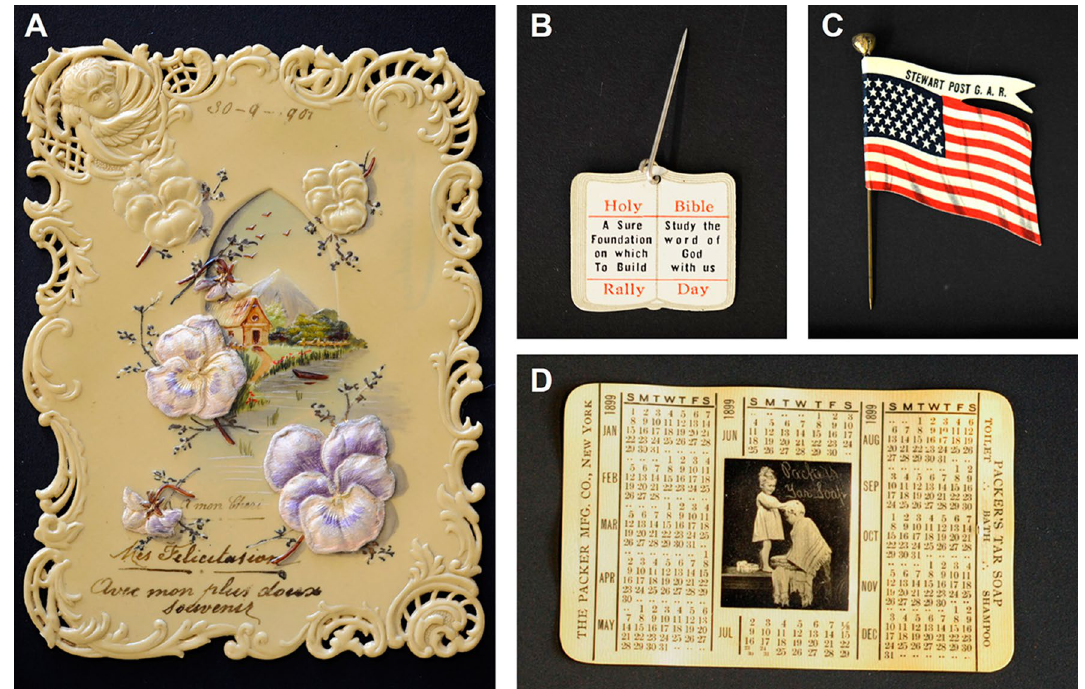
Figure 1. Objects from Perlov’s celluloid collection that consists of 300 everyday celluloid objects, donated by Amy Schenkein and Dadie Perlov, American collectors and majority donors of the Smithsonian Institute’s celluloid collection. Containing several objects of different types, from razor blades, fans, pins, postcards or advertising items, this collection is significant of the American technological advances in the celluloid industry from the 1890s to the 50s. The objects showed were studied in the framework of this research: a 1901 postcard ( A ), two undated advertisement pins, hereby called the holy bible pin ( B ) and the American flag pin ( C ), and an 1899 calendar ( D ).